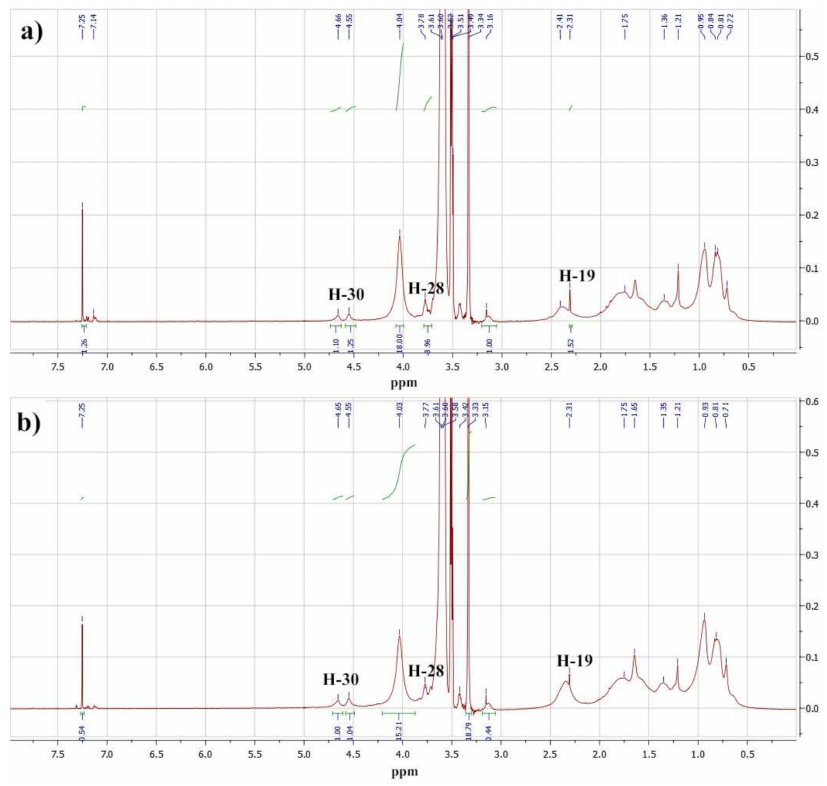
Figure 2. Fragments of the 1 H NMR spectra of the Bet-1 ( a ) and Bet-2 ( b )